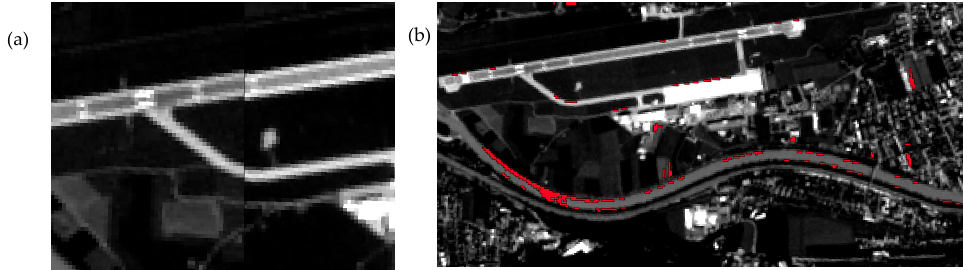
Figure 1. ( a ) Two images from Sentinel 2A on 2017 / 10 / 14 and Sentinel 2B on 2016 / 04 / 22 with Band2 (blue) blended to demonstrate the image-to-image misregistration for a location in Innsbruck, Austria. ( b ) The result of applying the change detection algorithm to an area in Innsbruck, Austria, where several pseudo changes are visible due to pixel shifts between the two images. This problem has been mitigated through applying a linear co-registration algorithm (see details in the text). (Source: Copernicus Sentinel Data 2016 /